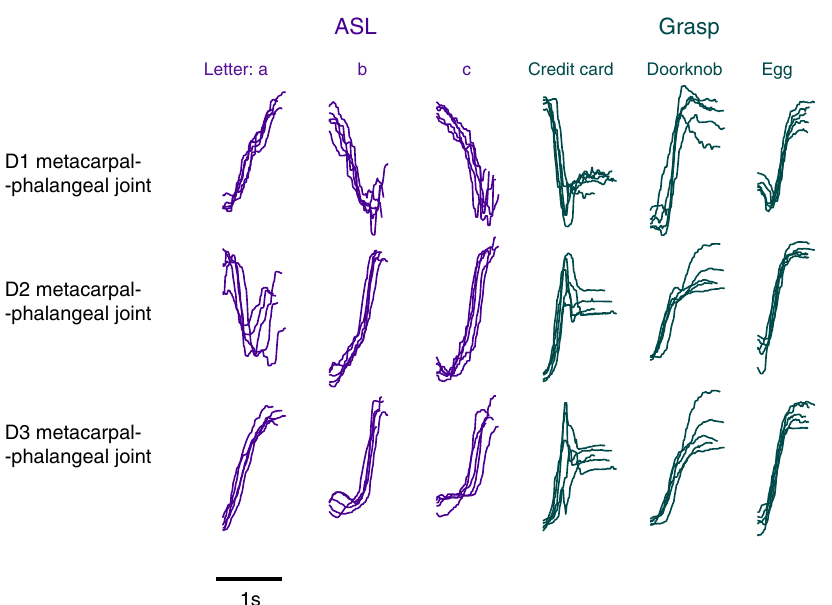
Fig. 2 Example kinematic traces. Joint kinematics (metacarpophalangeal joints fl exion of digits 1 – 3) when grasping three different objects or signing three ASL signs fi ve times each. Each trace shows a different trial of the same object/ASL sign.